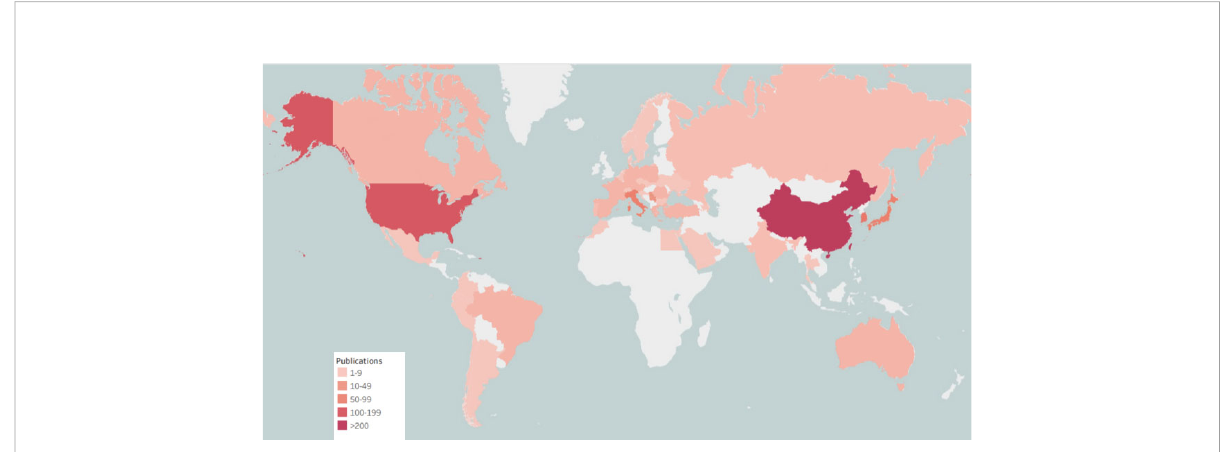
FIGURE 2 Global geographical distribution of PTMC